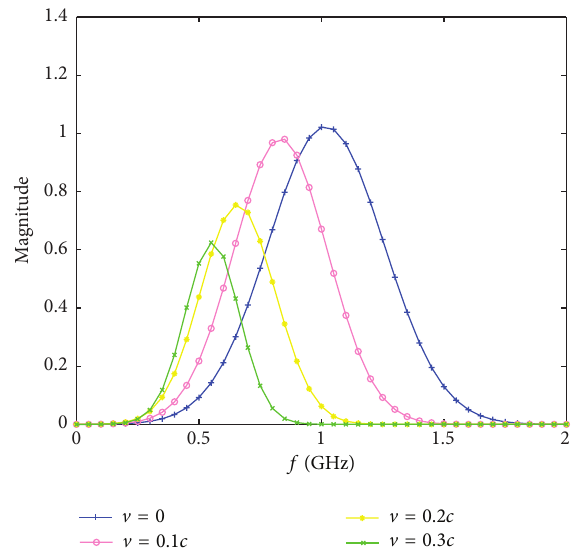
Figure 14: Frequency spectrums of the moving conducting square cylinder excited by the modulated Gaussian